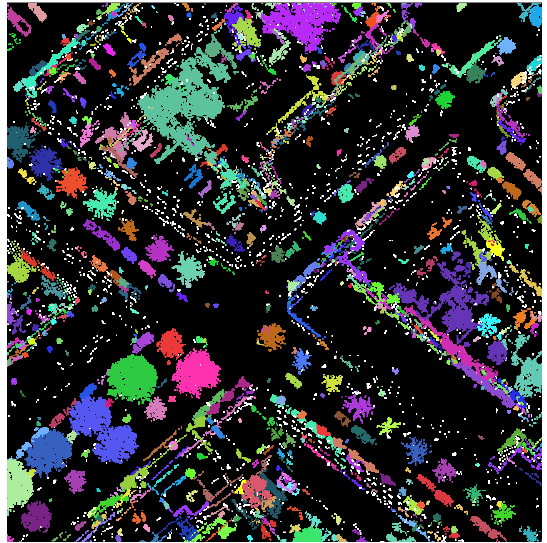
Figure 2. Connected components of points belonging to planar segments of less than 100 points.